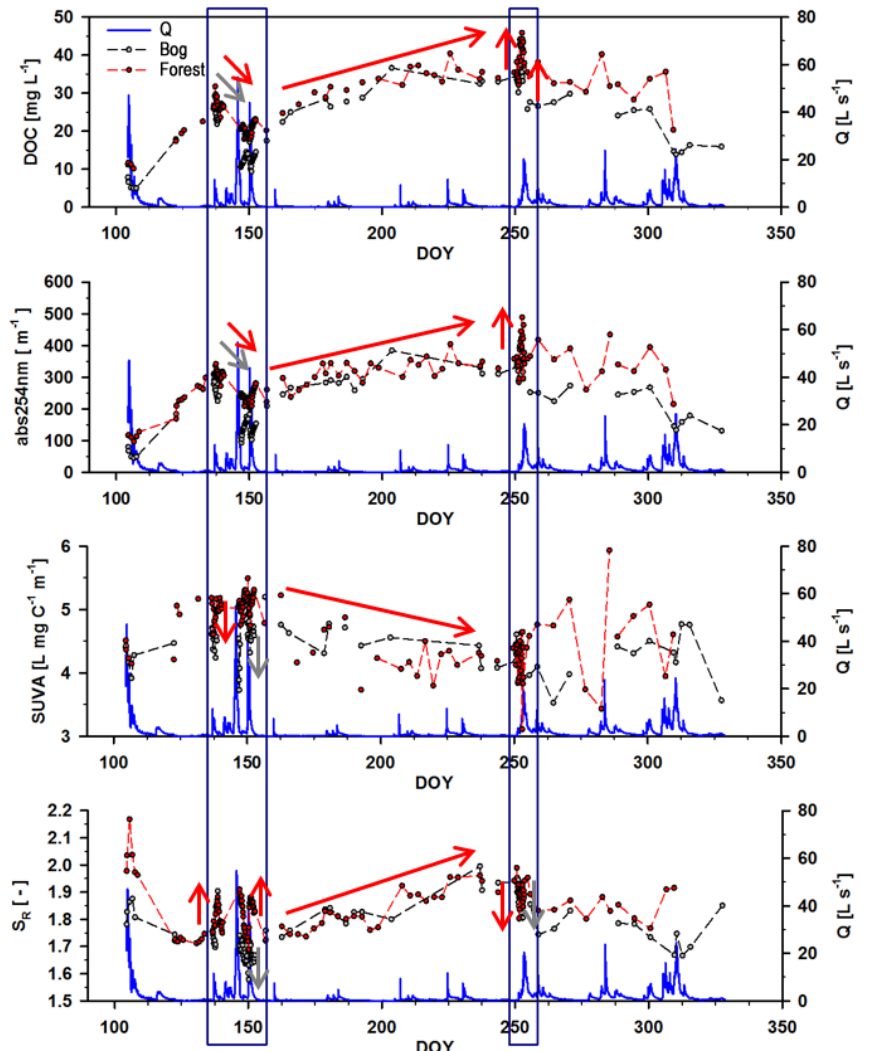
Figure 2. Annual records of DOC concentrations, abs 254nm , SUVA 254 and S R from top to bottom (DOY – day of the year) in 2013. The blue line represents the bog discharge ( Q ). Grey circles represent the bog site, red circles the forested site, while arrows indicate concentration or index trends during rain events and summer drought at the different sites. Sampled rain events in spring and fall are highlighted by blue